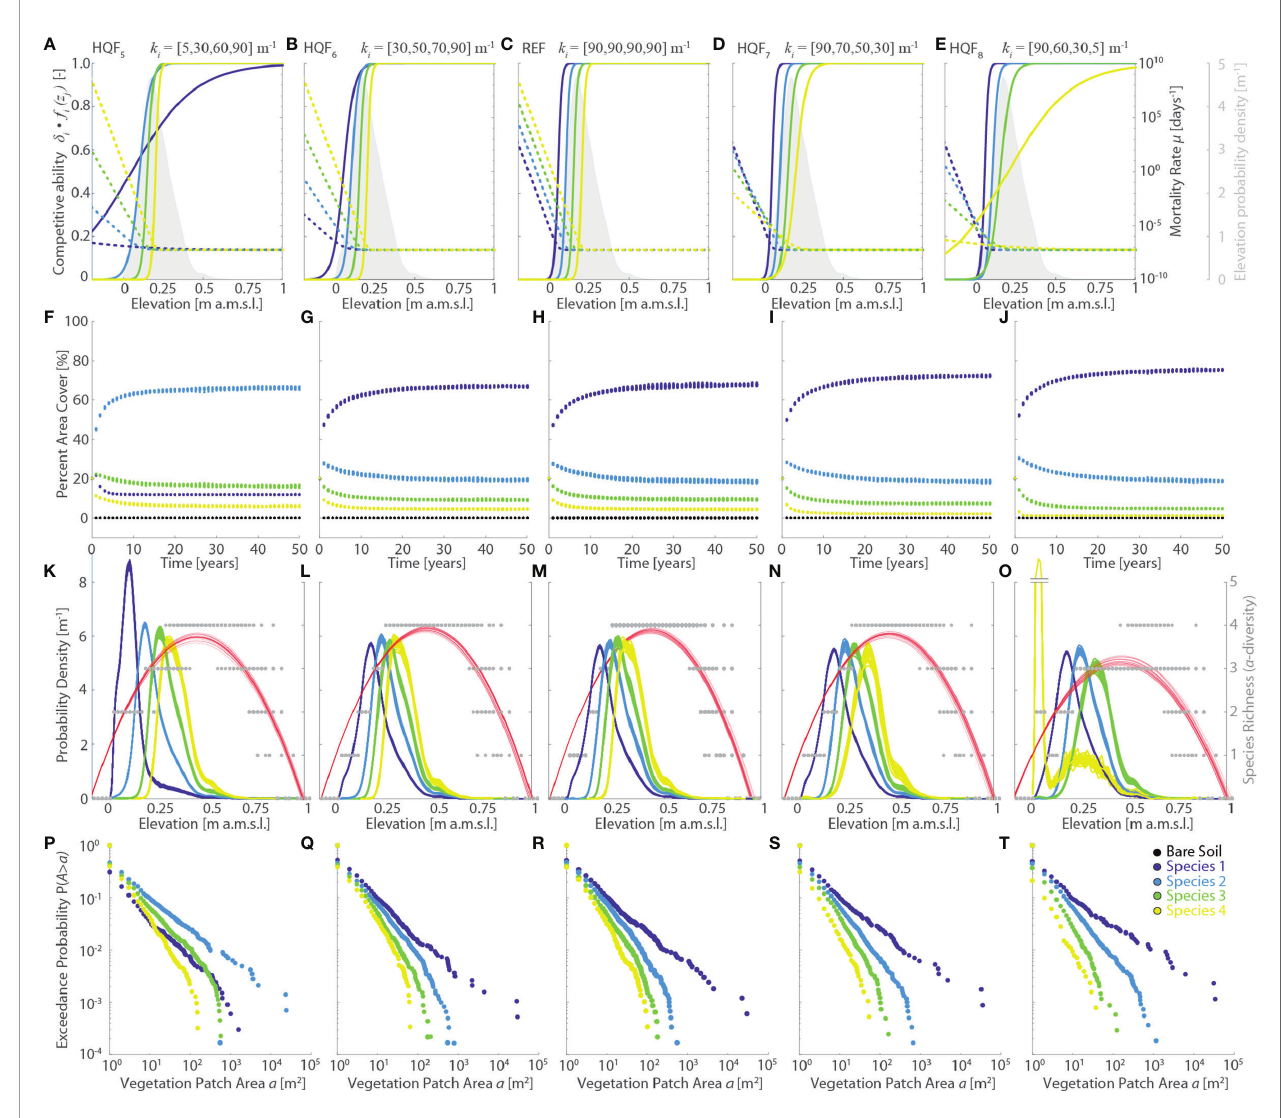
FIGURE 5 | Effects of changes in the vegetation habitat quality functions (HQF series, varying logistic rate k i ). Results of the reference simulation (REF, k i = {90,90,90,90} m -1 ) are shown in the central column. The fi rst and second columns report respectively the results of the HQF 5 ( k i ={5,30,60,90} m -1 ) and HQF 6 ( k i ={30,50,70,90} m -1 ) simulations, whereas the fourth and fi fth columns show the results of the HQF 7 ( k i = {90,70,50,30} m -1 ) and HQF 8 ( k i = {90,60,30,5} m -1 ) simulations, respectively. Each panel displays data derived from all the 20 numerical simulations performed for each scenario. Different colors denote different vegetation species, including bare soil, according to the legend shown in the lower-right panel. (A – E) Patterns of speci fi c competitive ability d i f i ( z j ) (continuous lines, left y-axis) and mortality rate µ i ( z j ) (dotted lines, right y-axis) as a function of local marsh elevation ( z j ). The gray area denotes the probability density estimates of marsh elevation within the computational domain. (F – J) Changes of percent vegetation cover over the whole simulation horizon. (K – O) Realized vegetation niches (left y-axis) and local species richness (i.e., a -diversity, right y-axis) as a function of marsh elevation at the end of the simulation horizon. Gray dots represent a -diversity point data with red lines showing the best quadratic fi t to point data. (P – T) Empirical probability distributions of spatially-continuous vegetation patch areas are shown based on the exceedance probability for a given vegetation patch